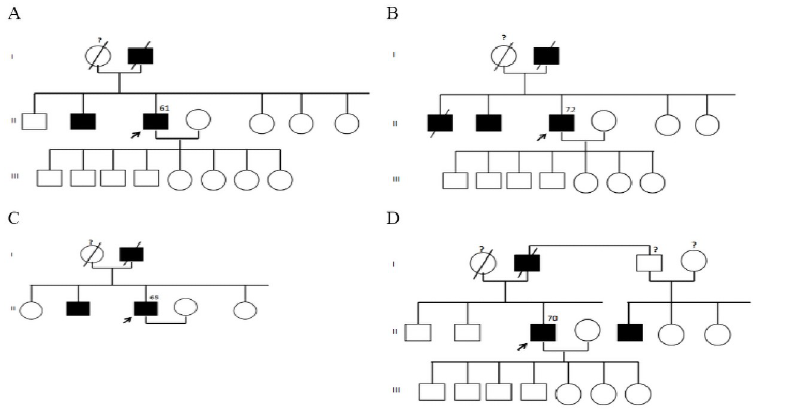
Fig 1. Pedigrees of patients carrying BRCA1 /2 deleterious mutations. (A) BRCA1 c.1953_1956delGAAA. (B) BRCA2 c.7234_7235insG. (C and D) BRCA2 delExon12. The numbers indicate age of patients at diagnosis.